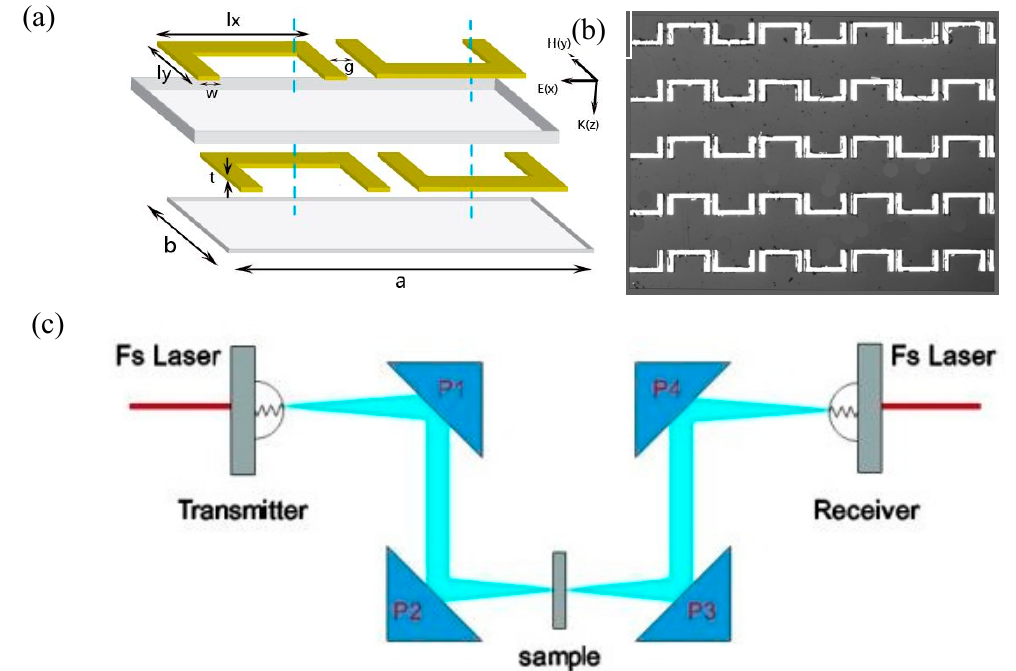
Figure 1. ( a ) Schematic of the proposed MMs (metamaterials) metamolecule. ( b ) Microscope image of the fabricated sample with g = 10 μ m. ( c )THz-TDS system.